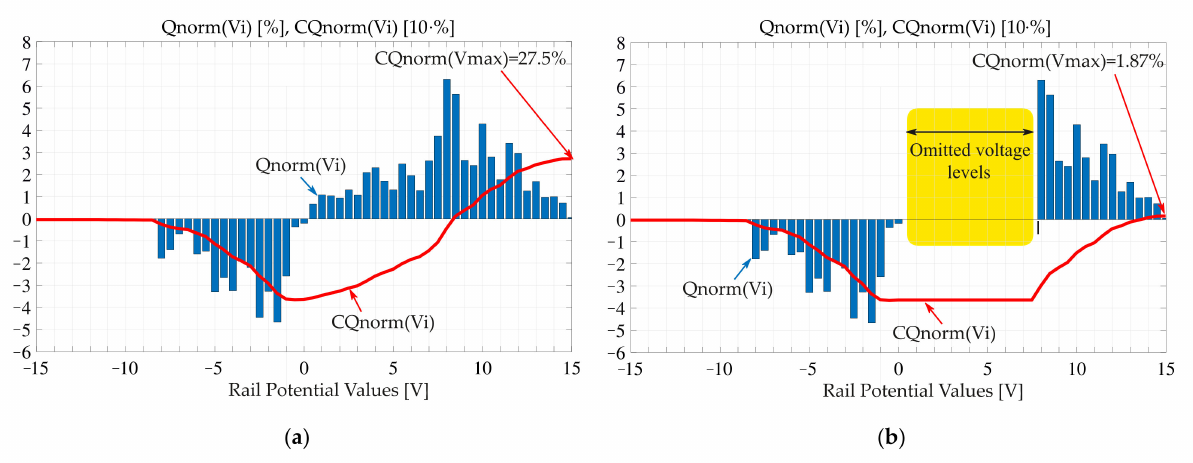
Figure 10. Comparison of the balance of charge (as a function of the rail voltage level) that flows between the rail and the earth for: ( a ) an unrestricted input current flow of the EH device; ( b ) a device using